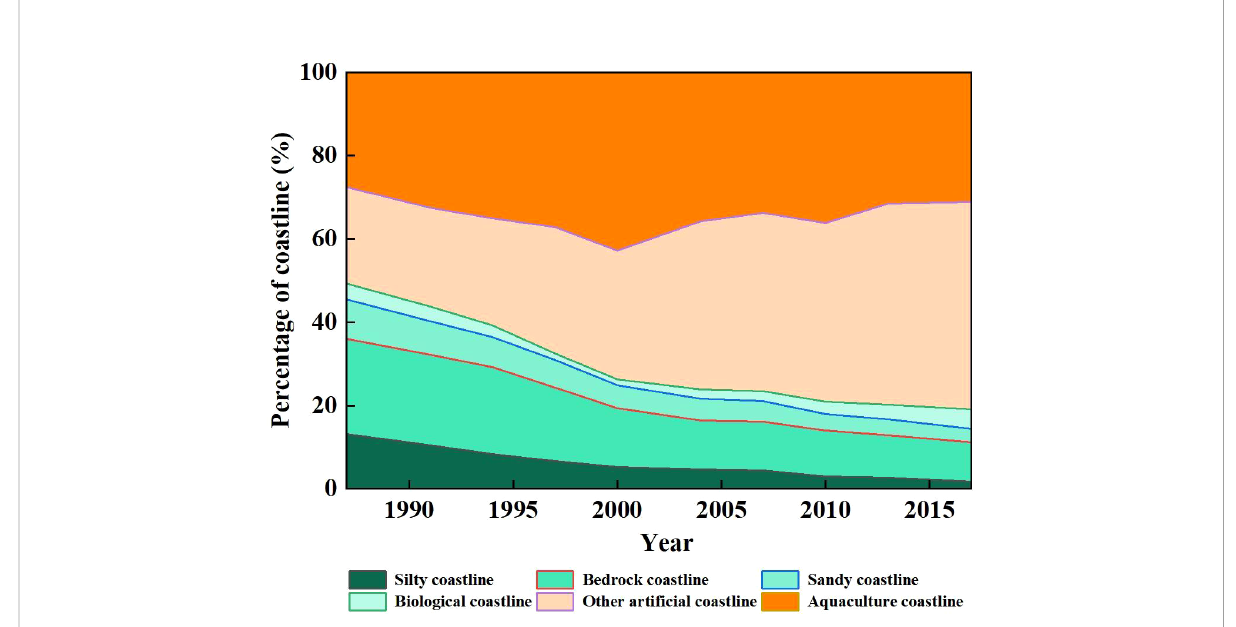
FIGURE 5 Variation in the different compositions of the coastline in the Pearl River Estuary during